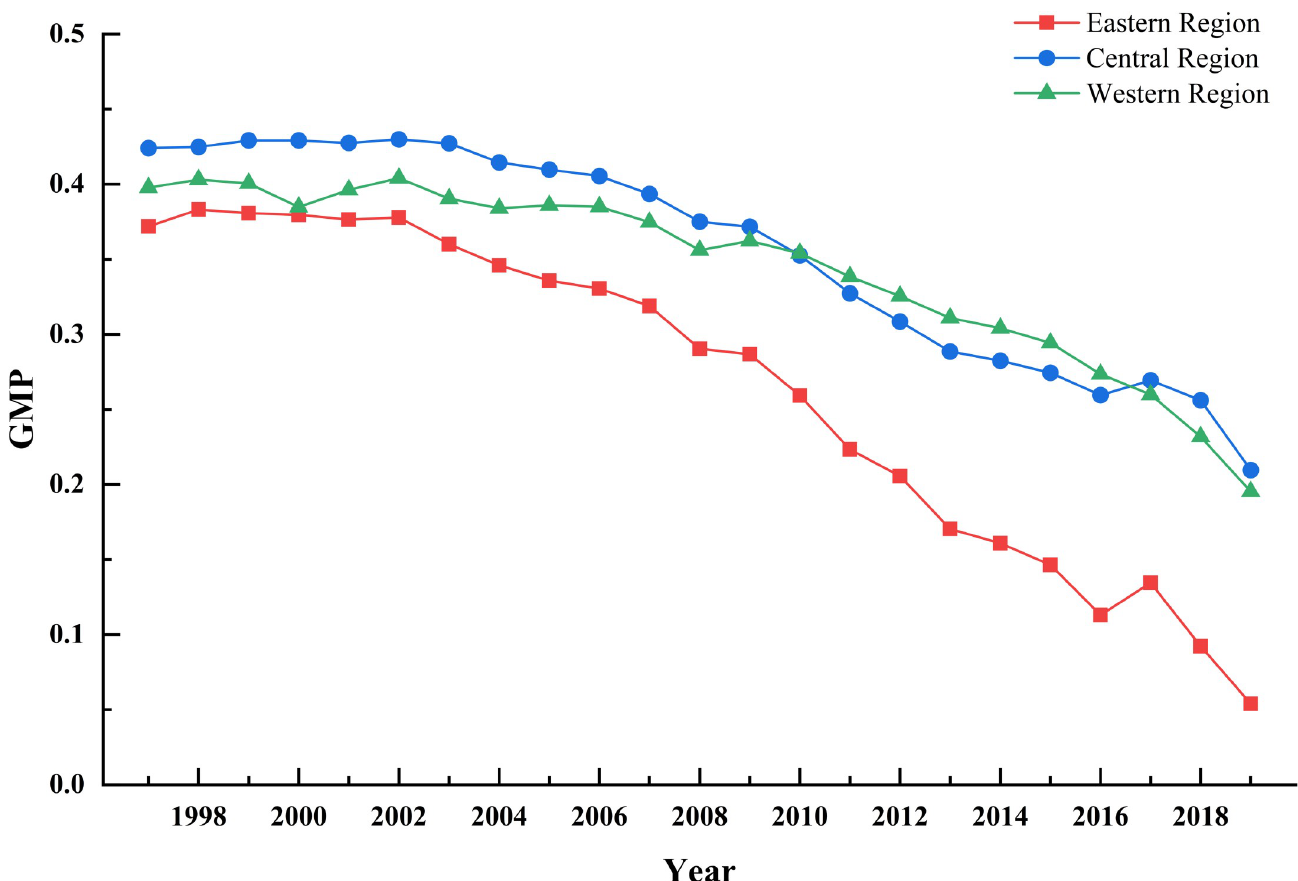
Fig 6. Changes in TGR in the eastern, central and western regions from 1997 to